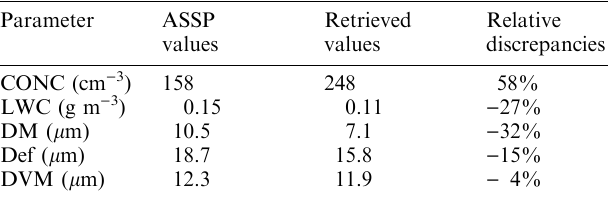
Table 3. Comparison between direct and retrieved microphysical parameters (CONC: cloud droplet concentration, LWC: liquid water content, DM: mean diameter, Def: mean e(cid:128)ective diameter and DVM: mean volume diameter). Results relative to mixed